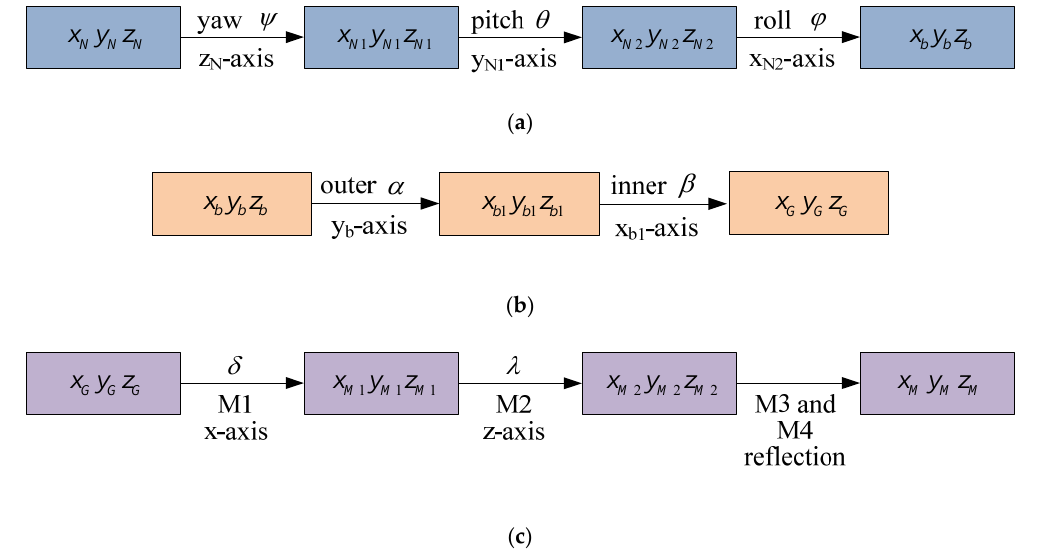
Figure 4. Transformation relationship ( a ) from the geographical coordinate frame to the aircraft body coordinate frame, denoted by b N C ; ( b ) from the aircraft body coordinate frame to the gimbal coordinate frame, denoted by G b C ; ( c ) from the gimbal coordinate frame to the mirror coordinate frame, denoted by M G C .